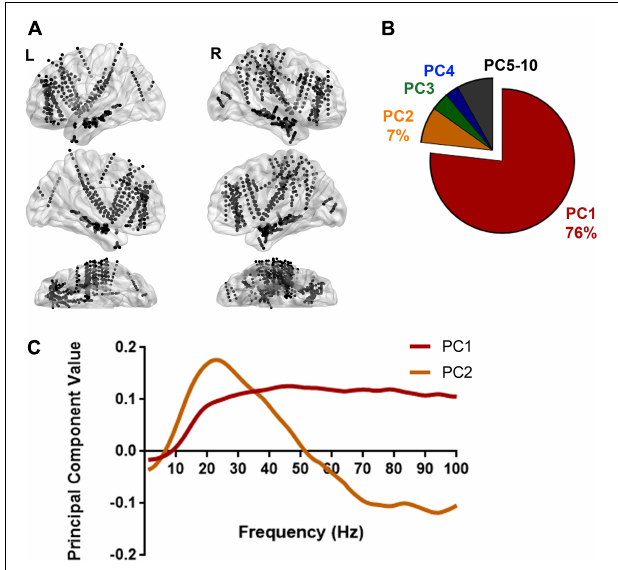
FIGURE 3 | Spectral pattern explaining the variation in power between Scr and Seq images. (A) Recording sites from 13 subjects are illustrated on a standard brain surface based on their MNI space coordinates. Each black dot indicates the location of one recording site. L, left hemisphere; R, right hemisphere. Supplementary Table 1 shows the full list of recording sites per subject. By calculating the averaged PSDs for every single recording site illustrated here ( N = 970 recording sites) using the approach described in Figure 2 , a total of 1940 PSDs were used to reveal the spectral variation in response to Scr vs. Seq image sequences. (B) Dimensionality reduction using principal component analysis (PCA) on all PSDs yielded the major principal components (PCs) that explain the variance among PSDs. A pie chart shows the distribution of percentage of variance explained by each PC. The primary PC (PC1) explained the majority of variance (76%). (C) The top two principal components (PCs) are plotted: PC1 exhibits a broadband variation in spectral power whereas PC2 showed a relative higher power in low frequency range and lower power at higher frequency bands. PCA was also applied to individual subjects and shows consistent patterns for the top PCs ( Supplementary Figure 3